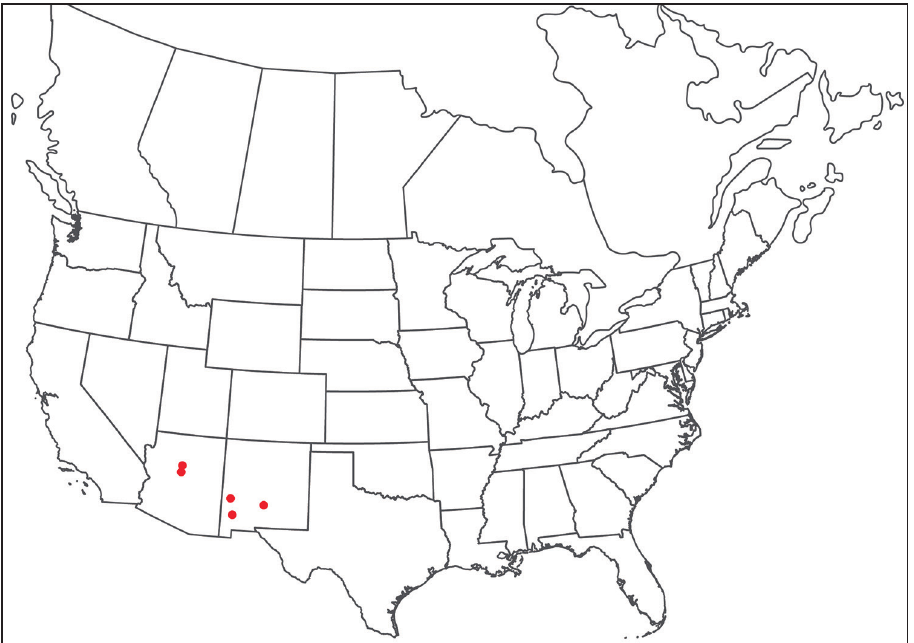
Figure 214. Torrenticola raptoroides sp. n.